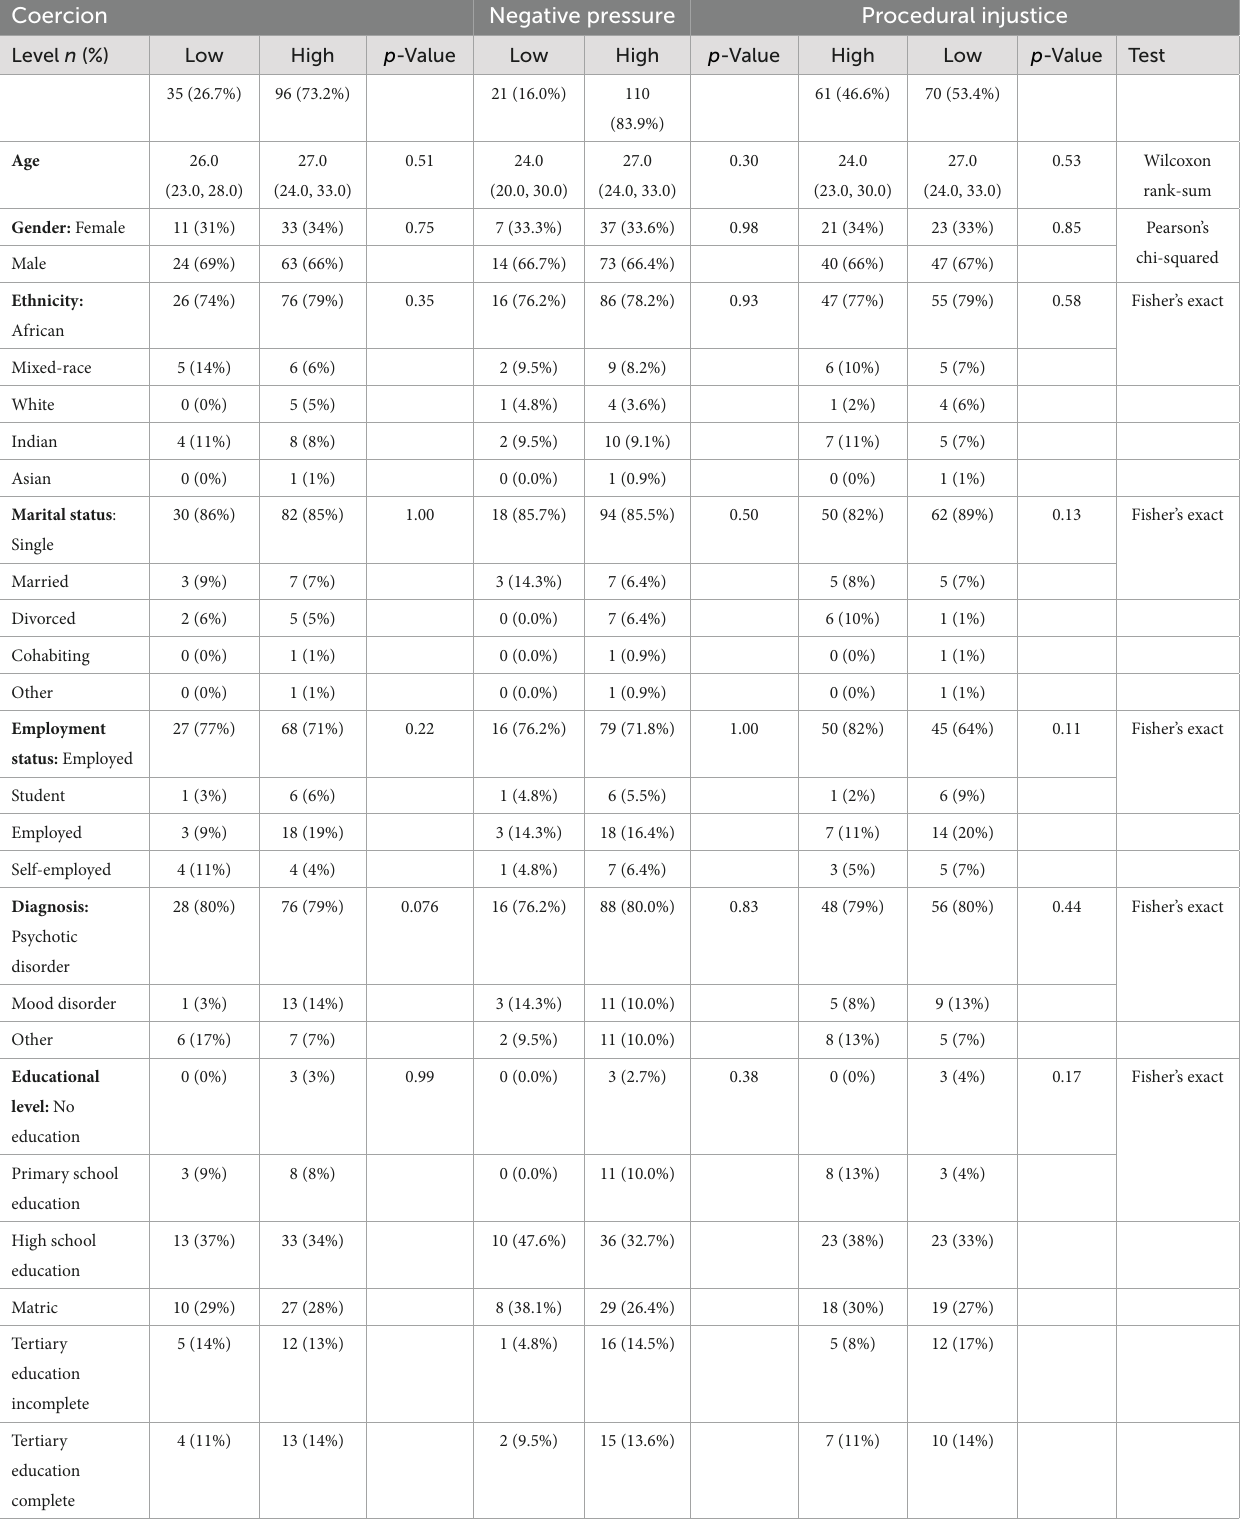
TABLE 3 Associations between MAES and sociodemographic factors. Coercion Negative pressure Procedural